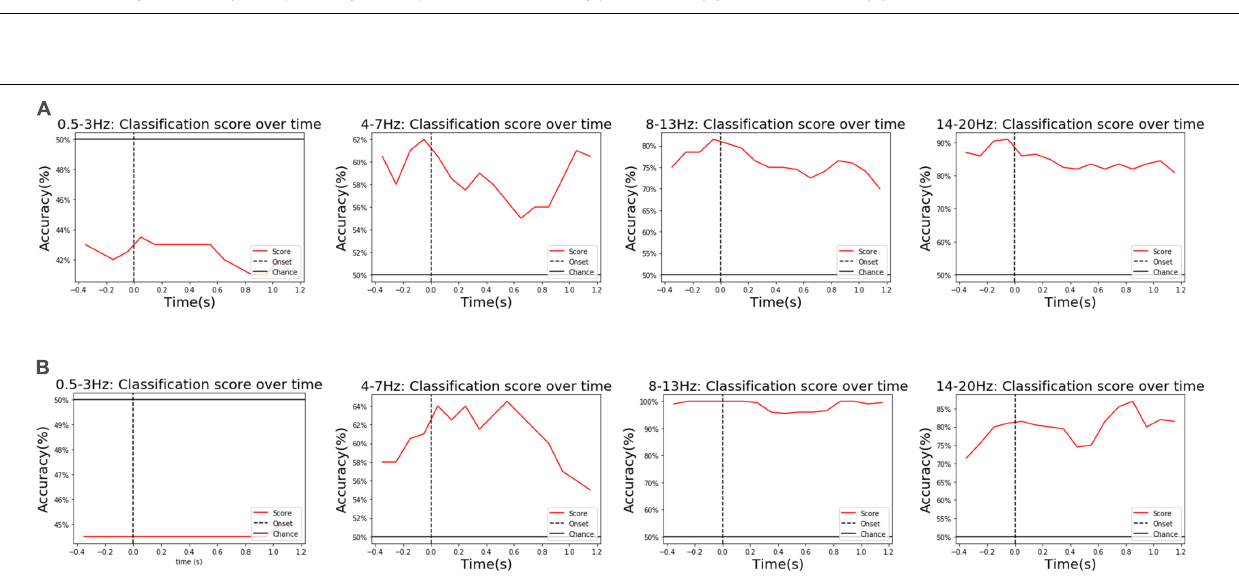
FIGURE 10 | An example of the diverse contributions for different subjects and wavebands. For example, a subject in the vibration task in (A) showed that β waves (above 14 Hz) had the greatest influence on classification performance, followed by α waves (8–13 Hz), while another subject also in the vibration task in (B) showed that α waves (8–13 Hz) had the greatest influence on classification performance, followed by β waves (above14 Hz).